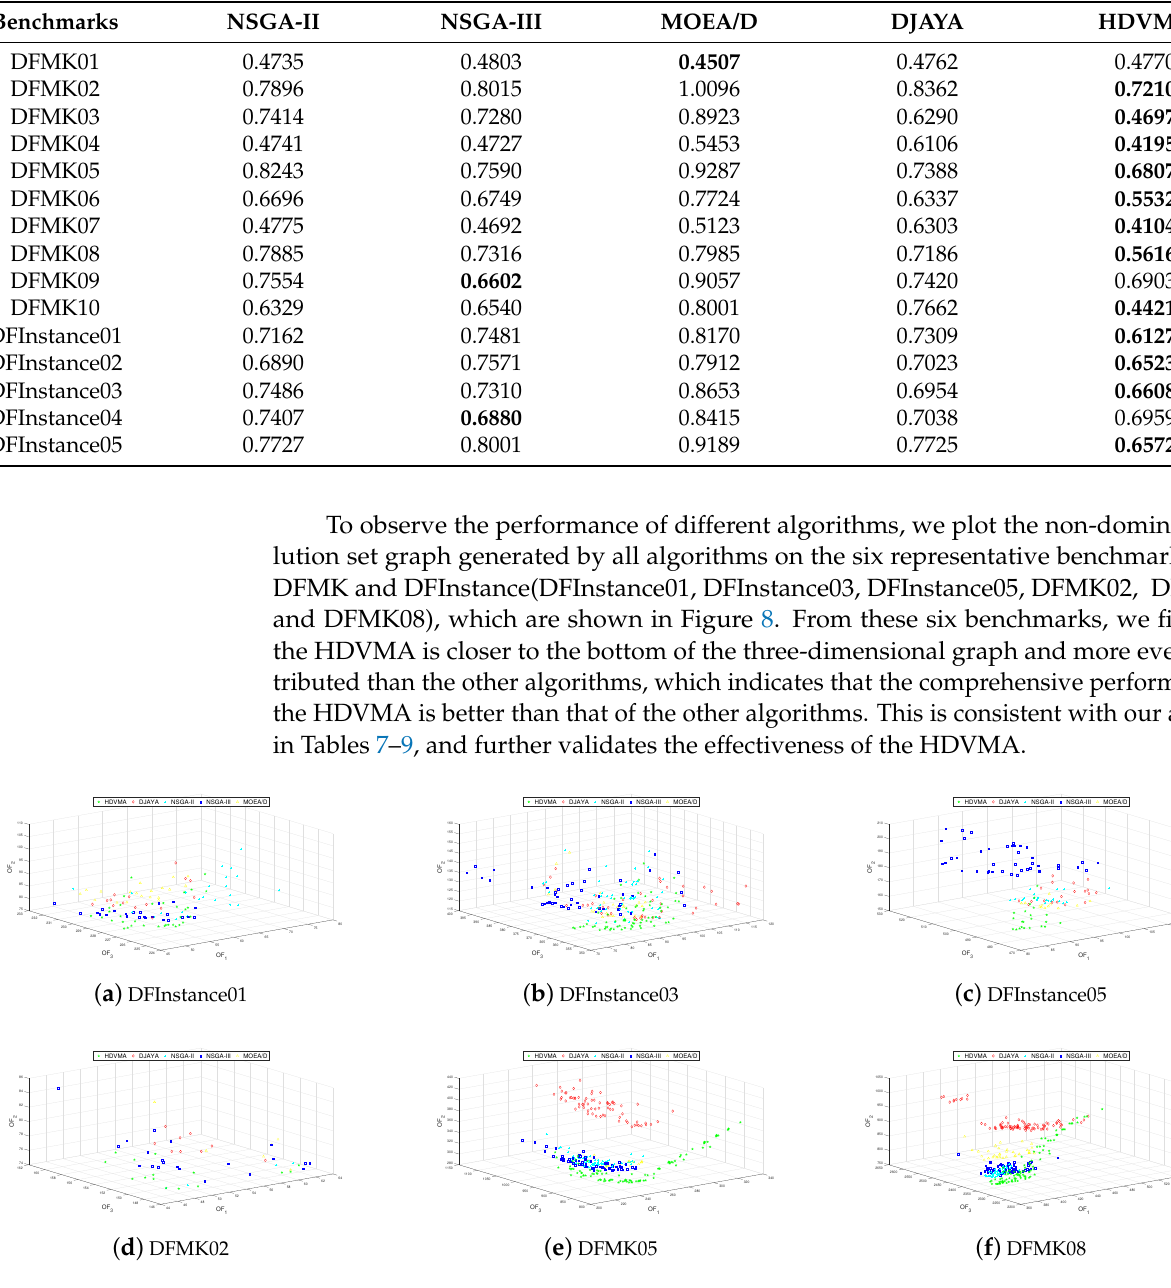
Figure 8. PF chart of select